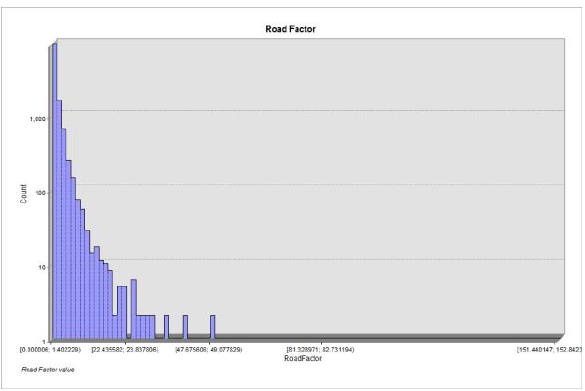
Figure 9 Road surface factor histogram Combining the road factor map with the original CO2 reduced map, the resultant map will be as illustrated in fig 10 a map of CO2 reduced values but aggregated using the factor from road surface.